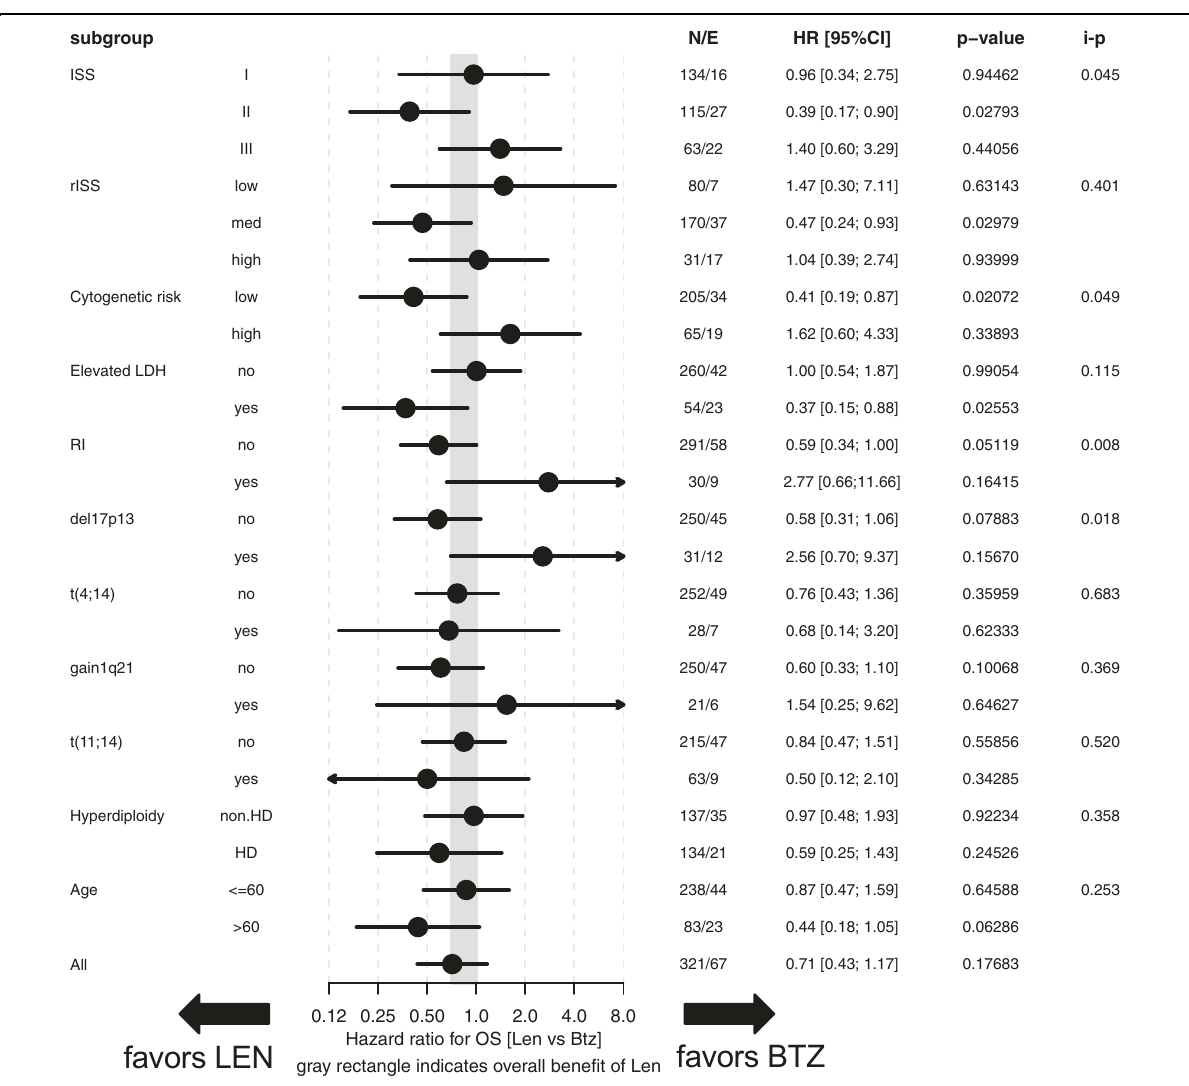
Fig. 3 Subgroup analyses on overall survival (OS) according to baseline factors. Multivariate subgroup analyses adjusted for response (CR/nCR vs.<nCR) were calculated for OS in the overall cohort. ISS international staging system, rISS revised ISS, cytogenetic risk: high vs. standard [ = low] risk; Elevated LDH: LDH (elevated [yes] vs. normal [no]); RI: renal impairment, de fi ned as serum creatinine (>2 mg/dl [yes] vs. <2 mg/dl [no]); Hyperdiploidy: cytogenetic hyperdiploidy